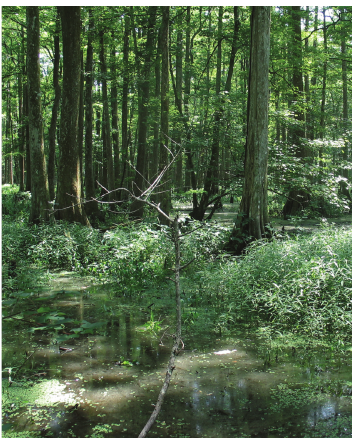
Figure 4: Cypress-tupelo swamp in Maurepas Swamp Wildlife Management Area, Saint James Parish, Louisiana.